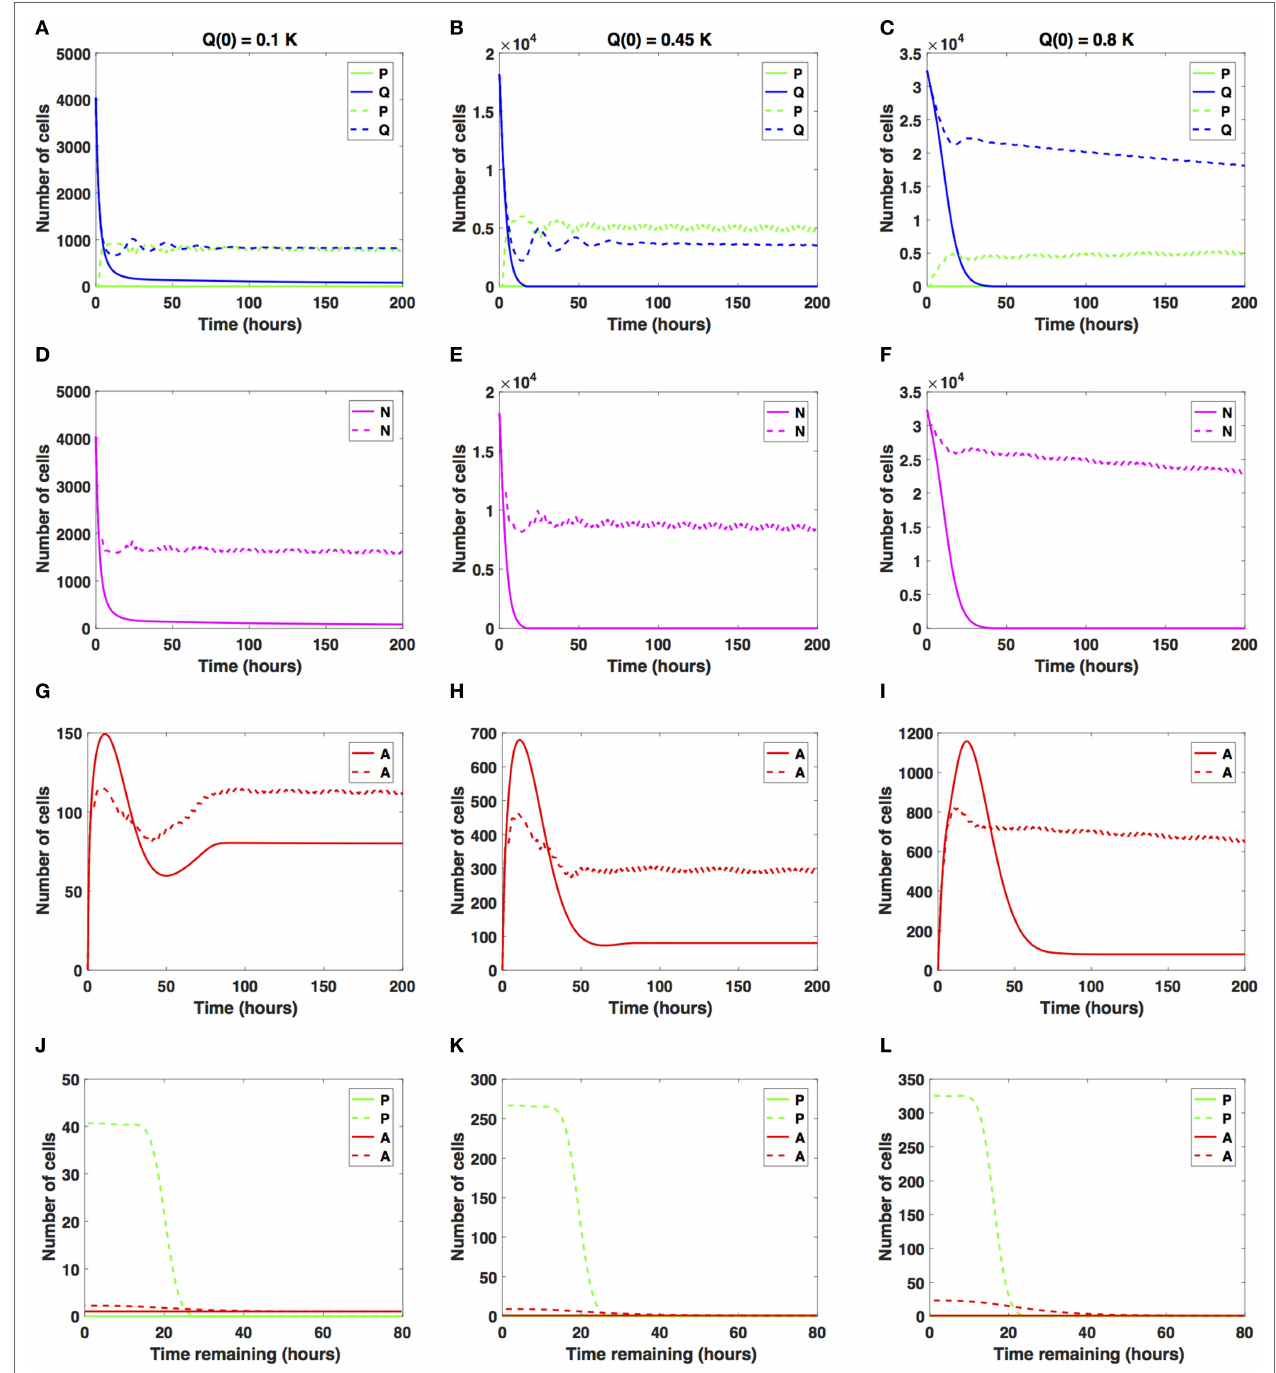
FIGURE 5 | Numerical solutions for the system (1)–(3) given large increases in the average cell-cycle length with (A,D,G,J) Q (0) = 10%, (B,E,H,K) Q (0) = 45%, and (C,F,I,L) Q (0) = 80% of the in vitro carrying capacity, K . The cellular dynamics in each compartment given a sustained, constant mitotic arrest or a switch-on/ switch-off arrest is illustrated using solid or dashed lines, respectively. (A–F) show the dynamics of the proliferating ( P ), quiescent ( Q ), and the total number of non-apoptotic cells ( N ). (G–I) show the dynamics of the apoptotic cells ( A ). Panels (J–L) illustrate the distribution of the times remaining to be spent by cells in the proliferative ( P ) and apoptotic ( A ) compartments as seen at the end of the simulation time, t = 200h, with (J) Q (0) = 10%, (K) Q (0) = 45%, and (L) Q (0) = 80% of the plate carrying capacity, K .